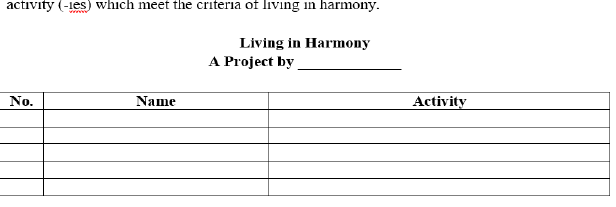
FIGURE 8 | Evaluation – Living in Harmony Take Home